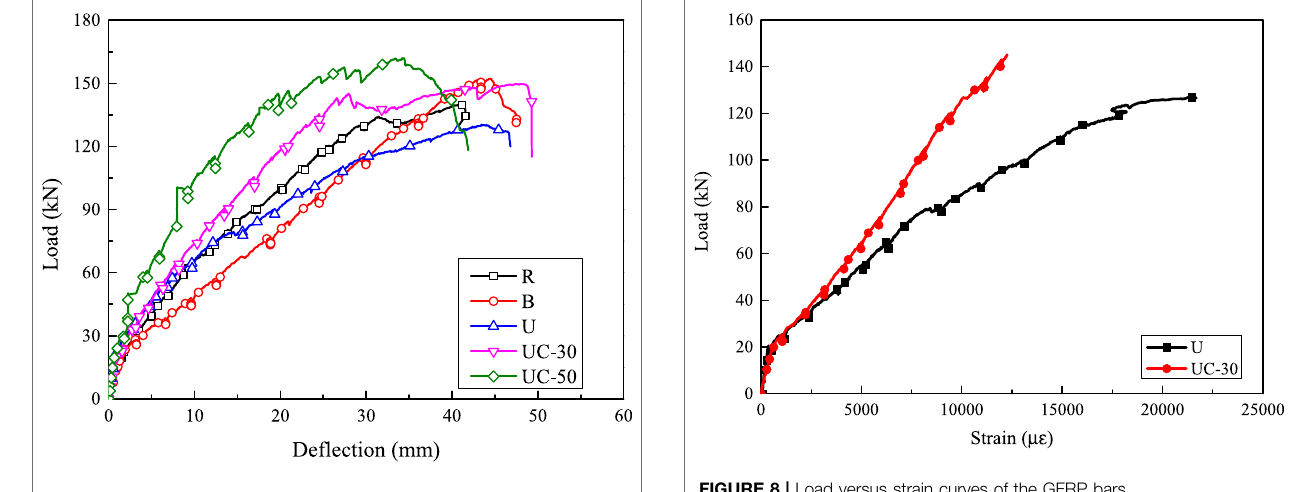
FIGURE 6 | Load versus mid-span de fl ection curves of all the tested beams.